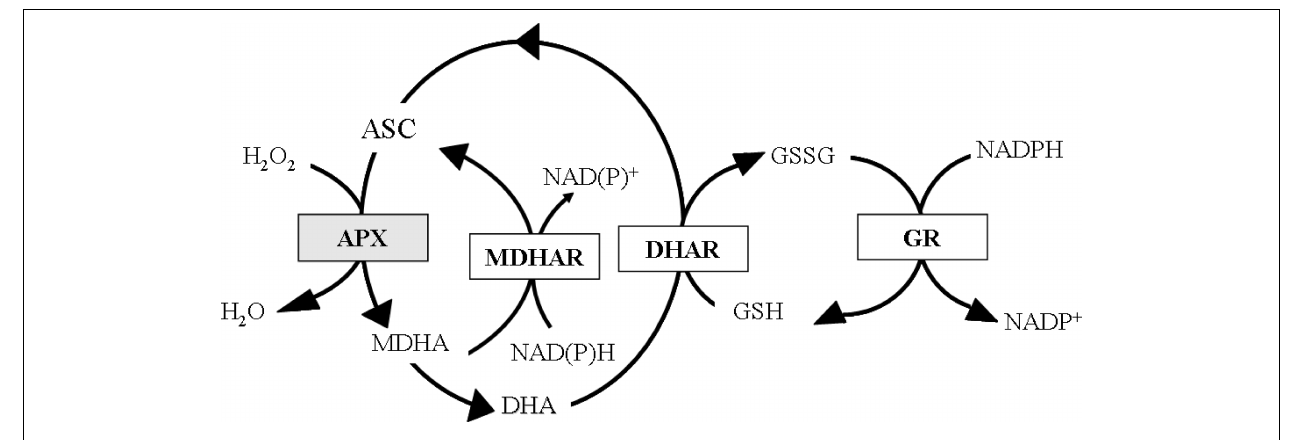
FIGURE 2 | Foyer- Halliwell-Asada cycle. Enzymes and intermediates of the cycle (also known as ASC-GSH cycle) are reported. In white boxes the enzymes active in both animal and plant cells; in gray box the enzyme